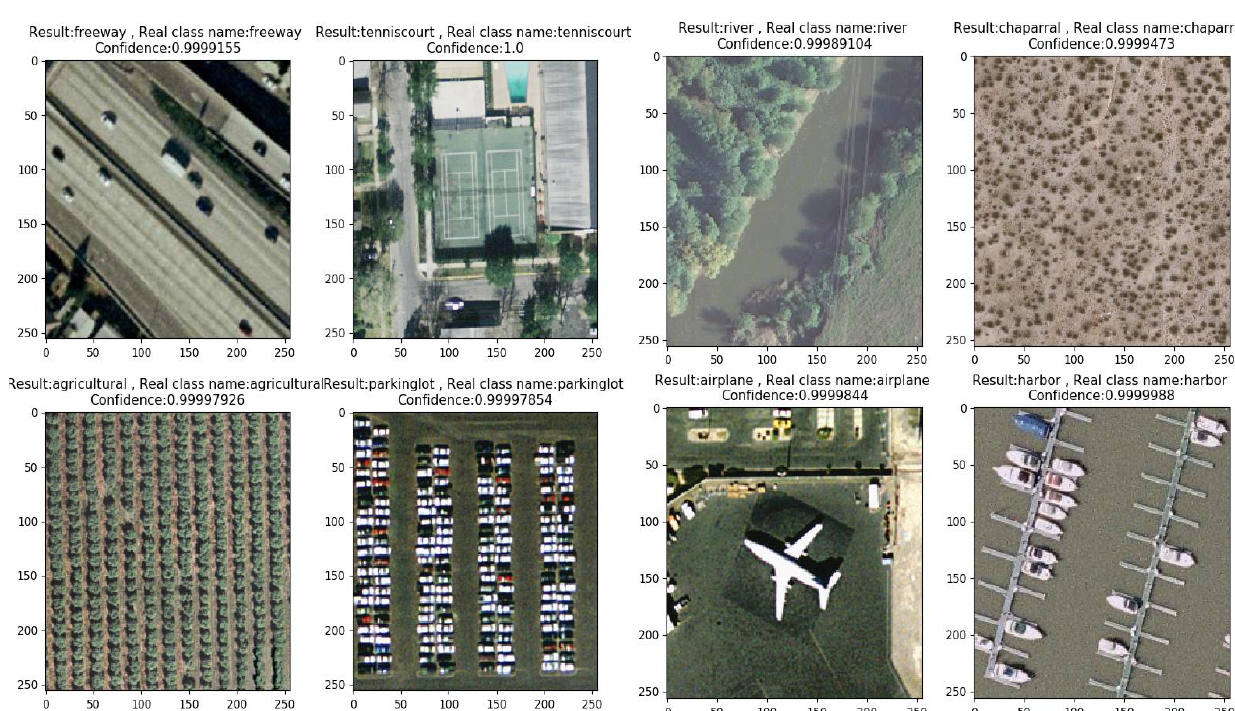
Figure 17. Classification results with randomly selected images.